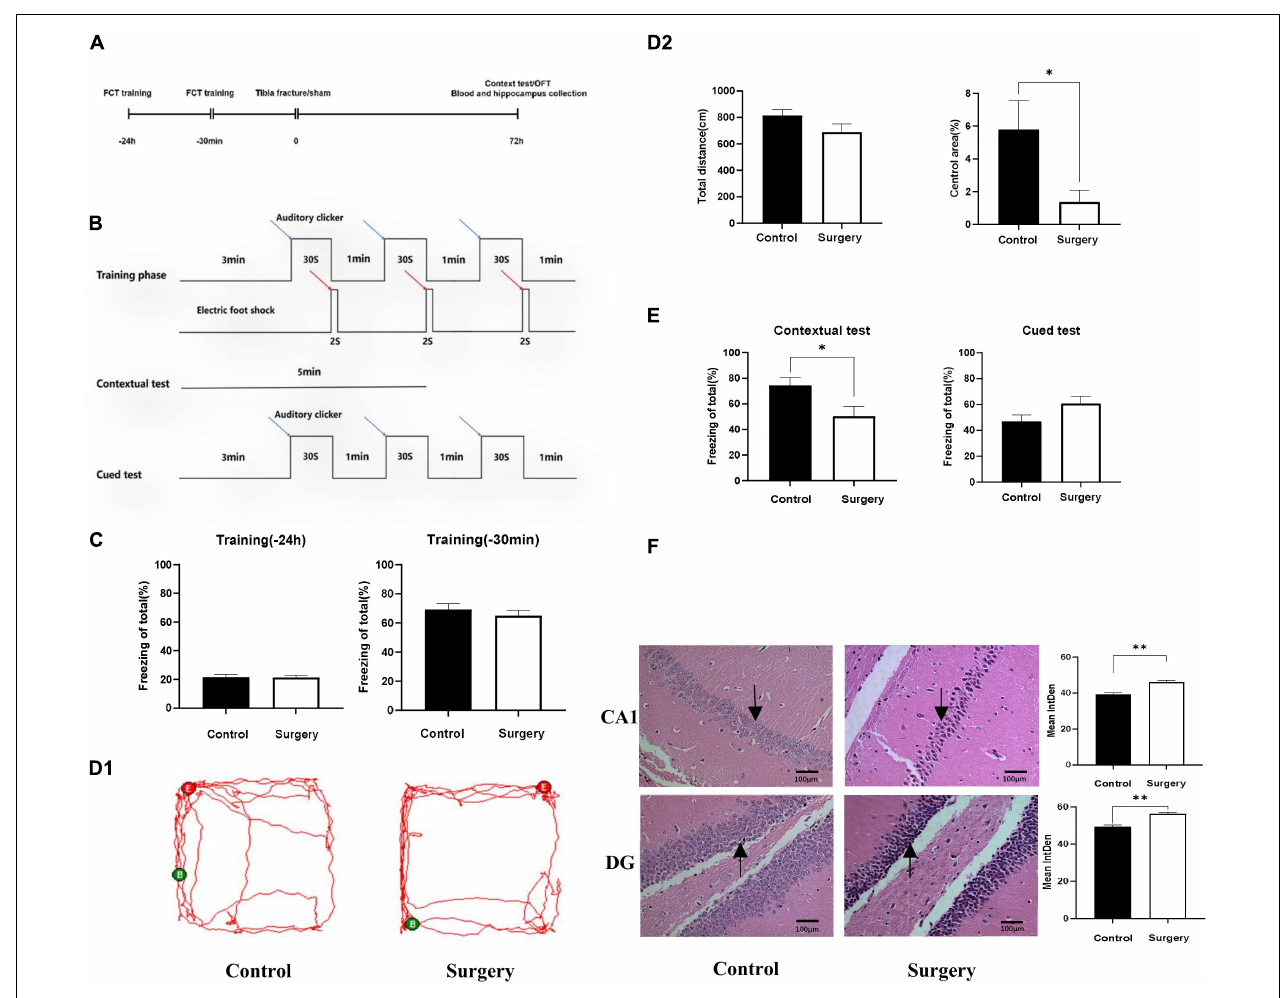
FIGURE 1 | Cognitive disorder induced by tibial fracture in aged mice. (A) Experimental design. (B) FCT experimental design. (C) Preoperative FCT training. (D1) Mice trajectory, Green (B) and Red (E) indicate starting and ending point. (D2) Travel distance and proportion in central area. (E) Contextual test and cued test. (F) HE staining, black arrow: neurons contracted and nerve fiber tangles. Data are presented as Means ± SEM, analyzed by Student’ s t -test. CA1, DG means the CA1, DG region of hippocampus. IntDen means Integrated Density, analyzed by Image J. ∗ P < 0.05 ( N = 9). * P < 0.05, ** P <